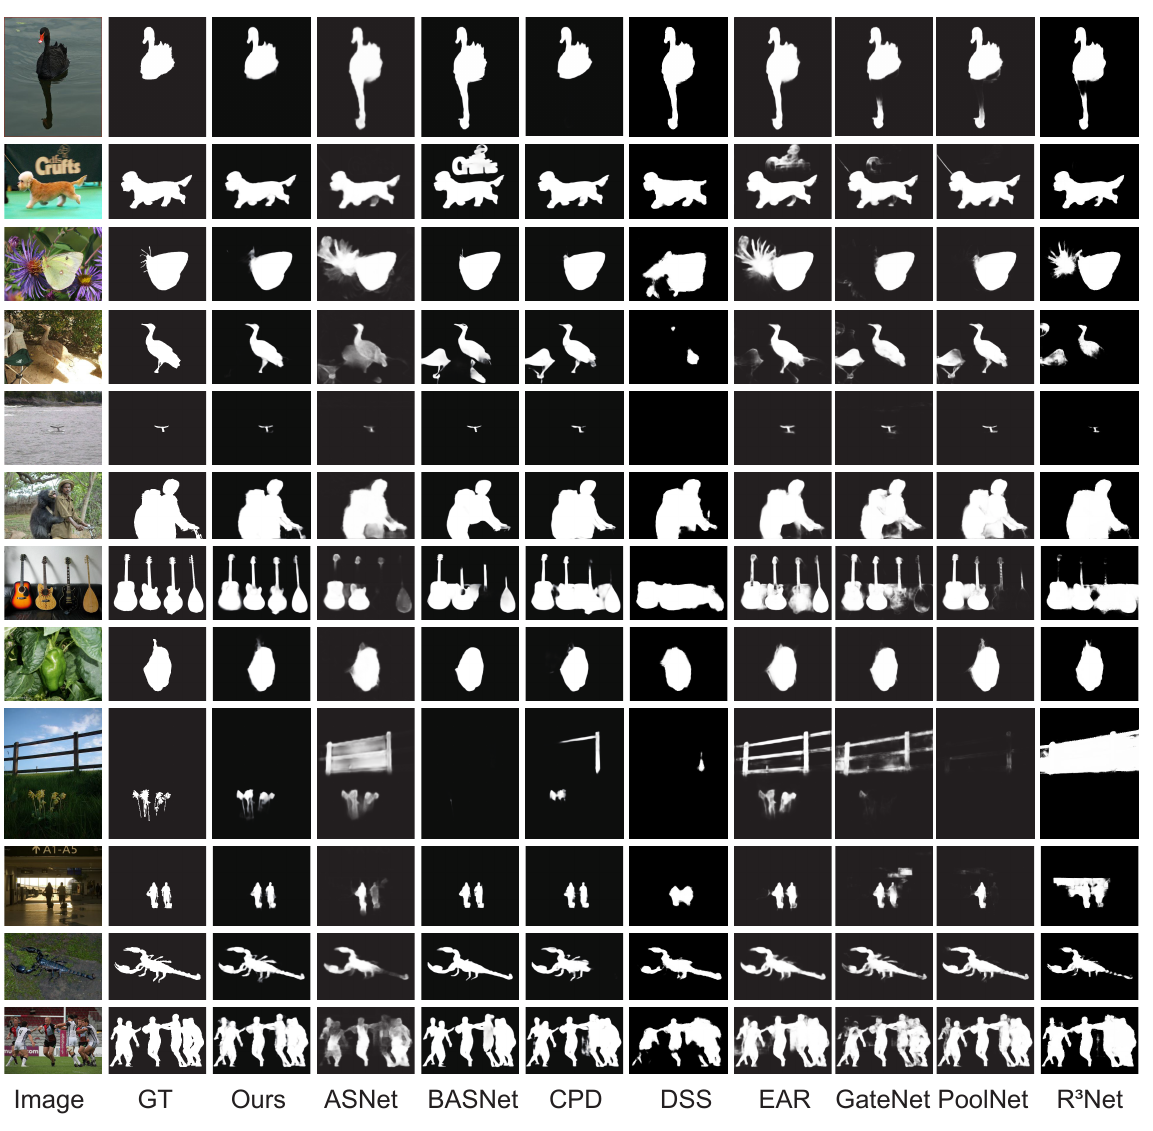
Figure 3. The visual comparisons between the proposed model and existing state-of-the-art algo- rithms on the prediction results from 12 representative